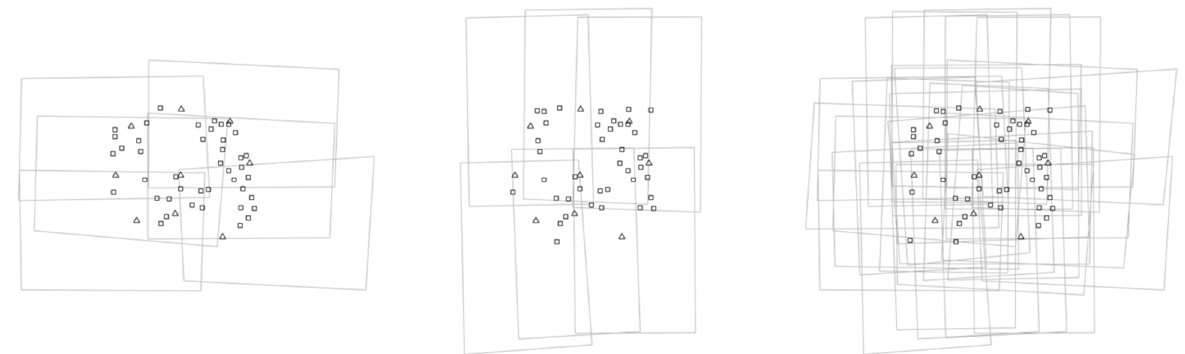
Figure 2. The distribution maps of all used known points, where triangles and squares denote the full GCPs and the full CHKs, respectively, and the image overlap of all used images in Case 1 (left), Case 2 (middle), and Case 3 (right) The observations include the photo coordinates of all tie points and the object coordinates of all ground control points (GCPs).